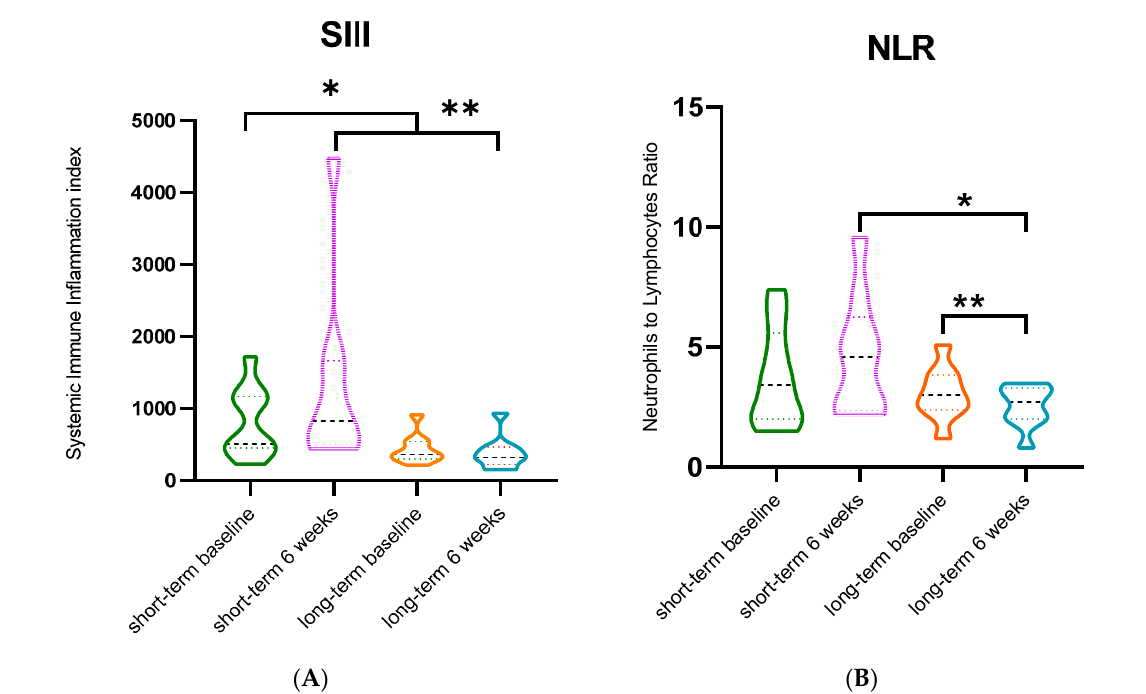
Figure 2. ( A ) Systemic immune inflammation index (SIII) in short-term survivors ( n = 9) and long- term survivors ( n = 9). *: p = 0.010 (Mann–Whitney U test); **: p = 0.0005 (Mann–Whitney U test_. ( B ) Neutrophil to lymphocyte ratio (NLR) in short-term survivors and long term-survivors. *: p = 0.006 (Mann–Whitney U test); **: p = 0.014 (Mann–Whitney U test).